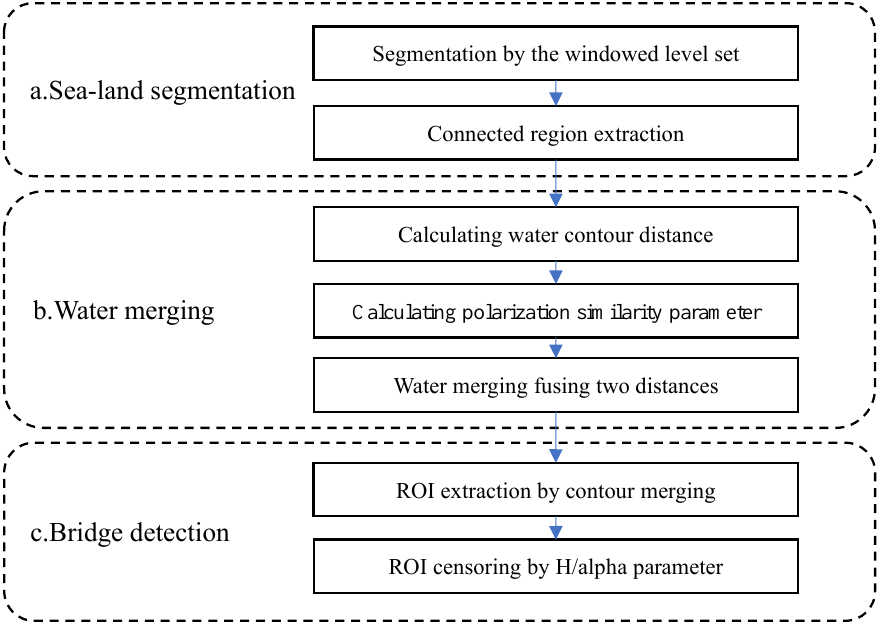
Figure 1. Diagram of the proposed method, where ROI denotes region of